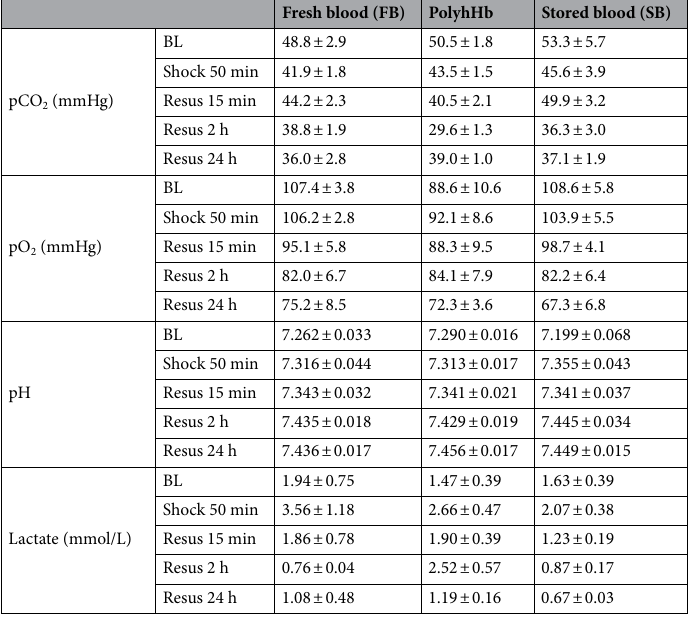
Table 1. Blood gases, pH and lactate levels. All resuscitation solutions preserved blood gases and pH within physiological ranges after resuscitation from HS. Moreover, all resuscitation solutions restored lactate to normal levels 24 h after resuscitation. Animals were awake at the 2 h and 24 h timepoints. Data was presented as the mean ± SE. BL (Baseline); HS (Hemorrhagic Shock); Resus (Resuscitation). No statistical differences were detected between groups in blood gases, blood pH, or blood lactate. Statistical comparisons were completed using a two way-ANOVA; Tukey’s multiple comparison